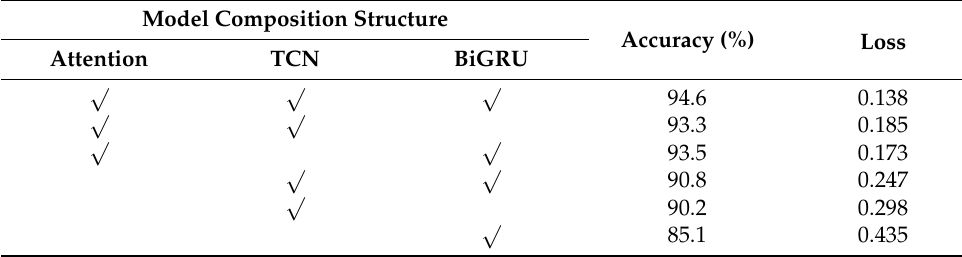
Table 11. Results of ablation experiment.